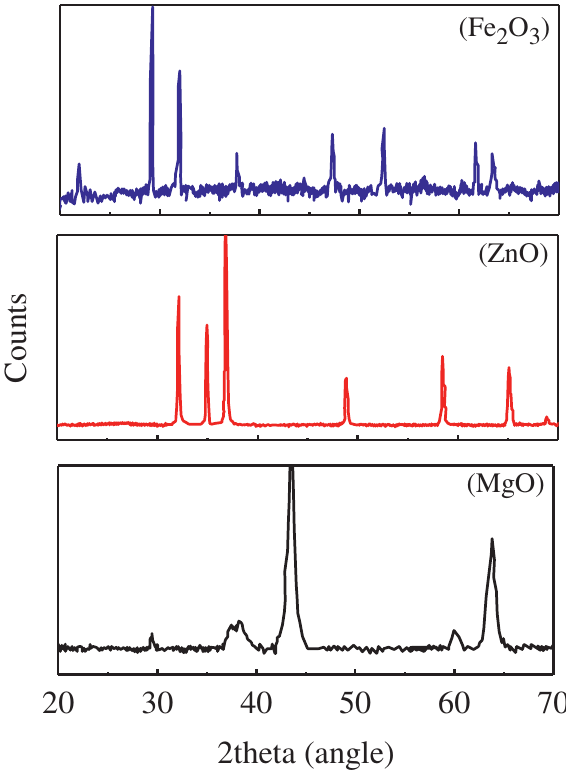
Figure 2: XRD patterns of pure Fe 2 O 3 , MgO and